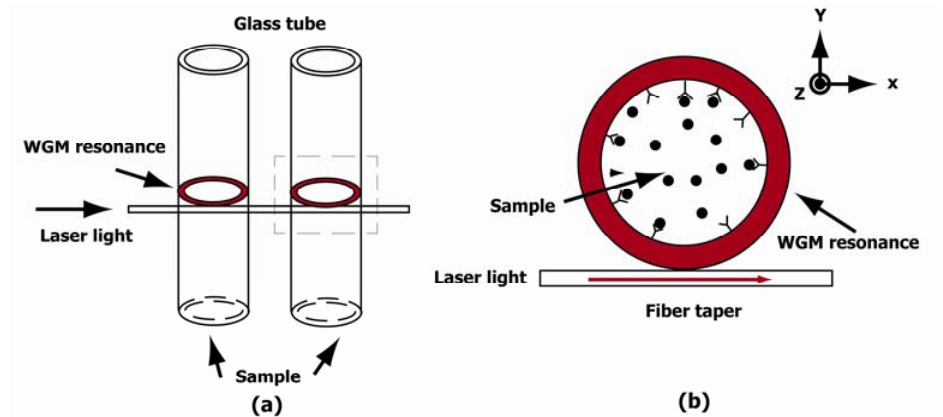
Figure 1. The schematic of ( a ) the multi-channel OFRR and ( b ) a section